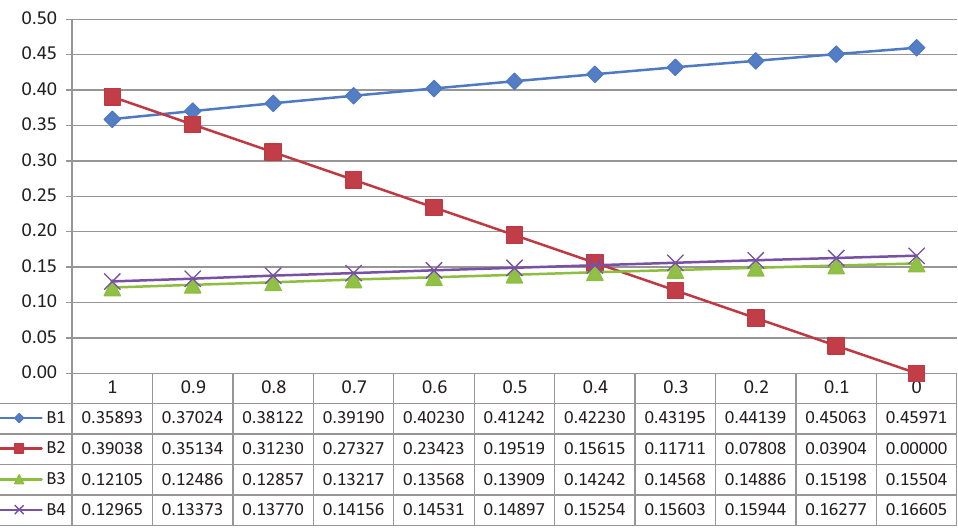
Figure 5. Results of the sensitivity analysis for the factor Motor Travel and Congestion Reduction